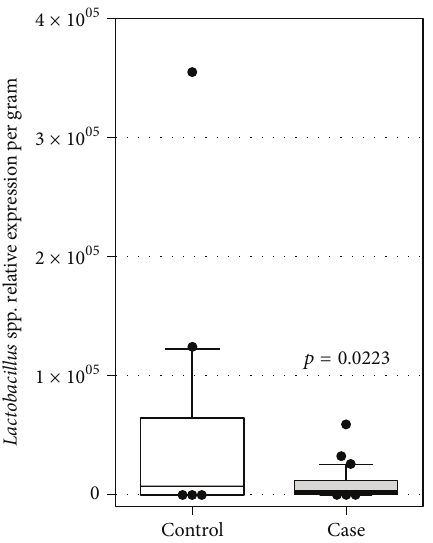
Figure 1: Total bacterial 16S rRNA gene copies detected per gram of healthy (control) and constipated (case) children stools ( 𝑛 = 29 for each population). Box plots show the 10th to 90th percentile range of the data within the box, with outliers indicated as dots. 𝑝 value with 95% CI was calculated by 𝑡 -test.